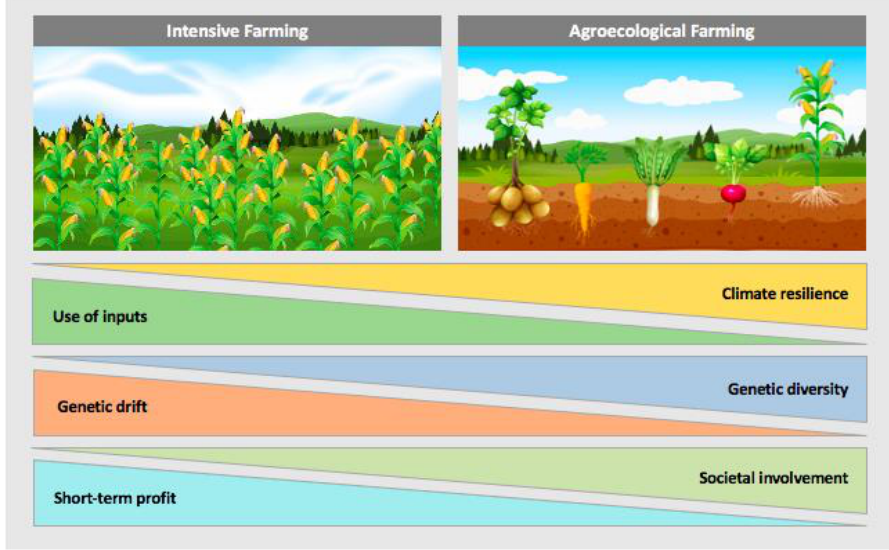
Figure 4. Major differences between intensive farming and agroecological farming.